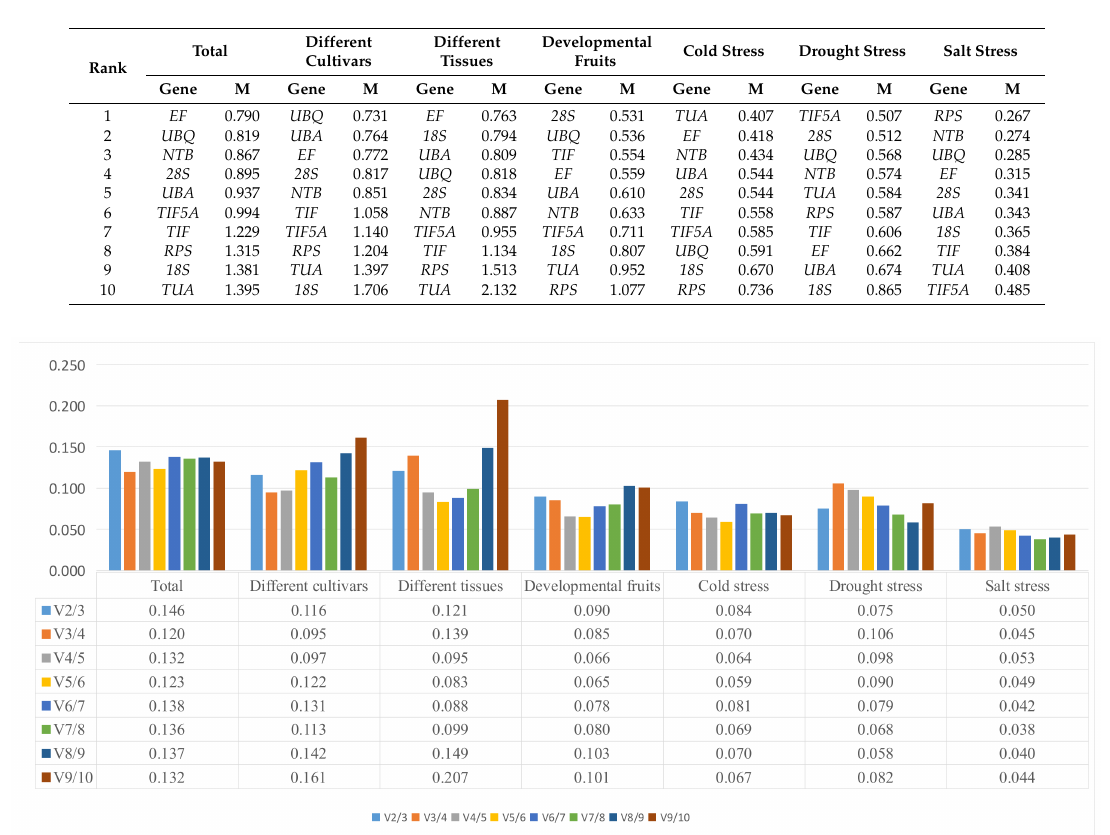
Table 3. Ranking of the candidate reference genes according to their stability value using geNorm.